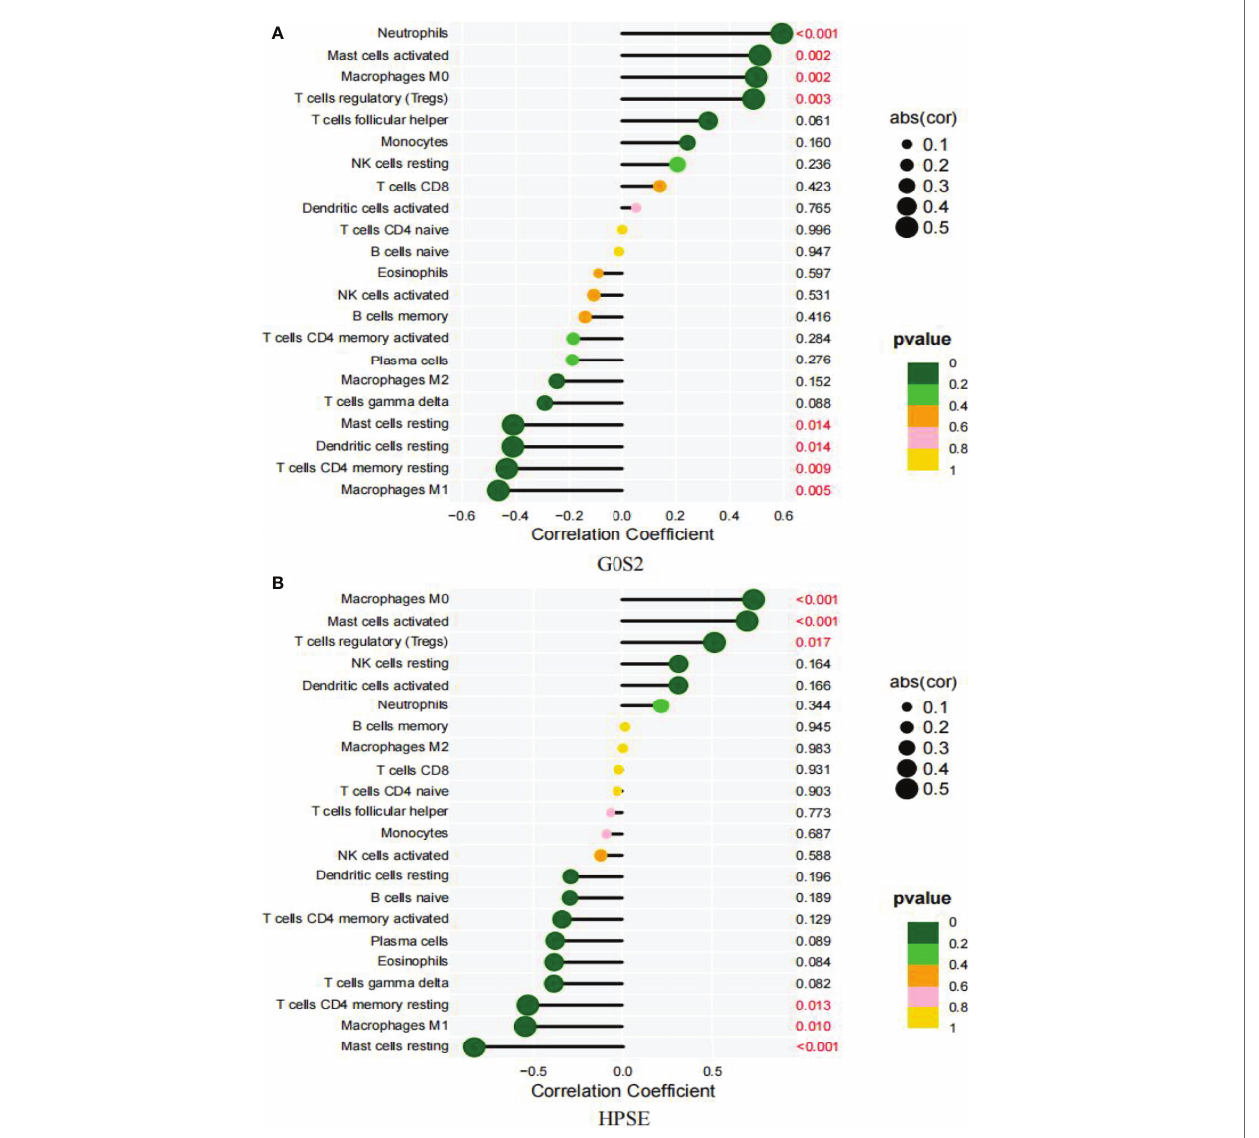
FIGURE 10 | Correlation between diagnostic markers and in fi ltrating immune cells. (A) Correlation between G0S2 and in fi ltrating immune cells. (B) Correlation between HPSE and in fi ltrating immune cells. The size of the dots indicates the degree to which genes and immune cells are correlated. Correlation strength is proportional to the size of the dots. The color of the dots indicates the P-value; a yellower hue indicates a lower P-value, while a greener color indicates a higher P-value. P-value < 0.05 was considered statistically signi fi